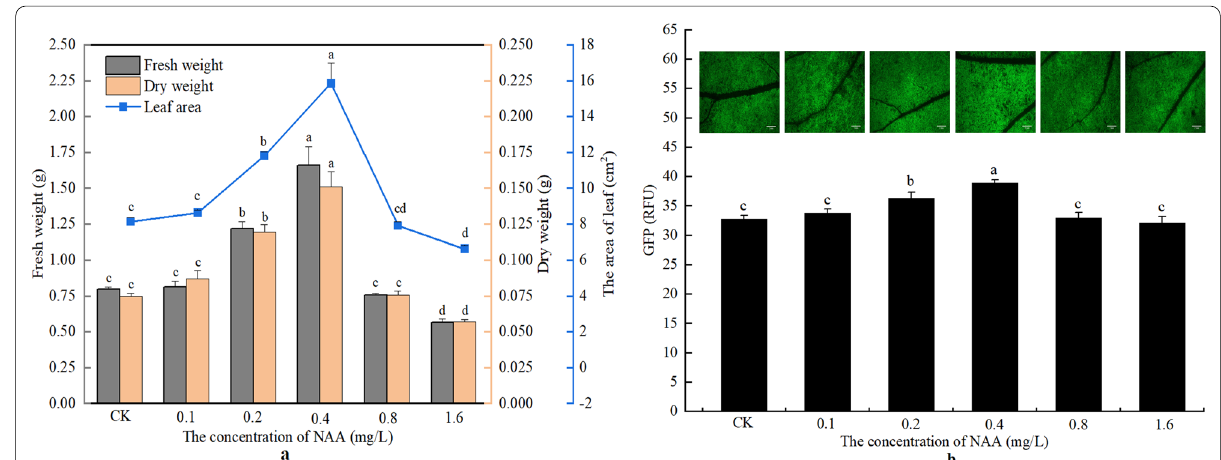
Fig. 1 The changes in biomass and GFP fluorescence intensity of seedlings under different NAA concentrations. a The changes of fresh weight, dry weight, and leaf area of the seedlings after treatment with different concentrations of NAA. b The changes in GFP fluorescence intensity in the leaves of the seedlings treated with different concentrations of NAA. Bar 2 mm. CK, Treatment with water; NAA, α‑naphthalene acetic acid. The = values of RFU (relative fluorescence unit) are average standard error (SE) of three individual replicates. Different lowercase letters indicate that ± there are significant differences in the same parameter among the treatment with different concentrations of NAA at the P < 0.05